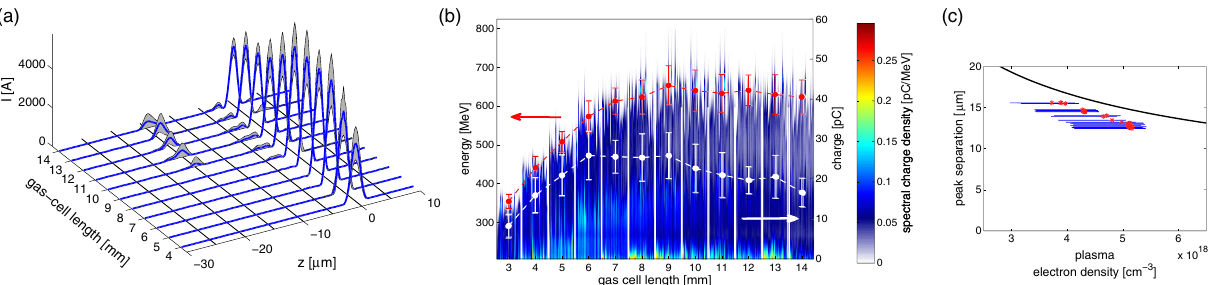
FIG. 4. (a) Bunch profile evolution at a plasma electron density of n e ¼ 3 . 9 × 10 18 cm − 3 : Retrieved bunch profiles averaged over 30 consecutive shots for different gas-cell lengths. The grey band shows (cid:3) 1 σ , where σ is the shot-to-shot standard deviation for each 30-shot data set. (b) Electron energy evolution at n e ¼ 3 . 9 × 10 18 cm − 3 : Measured electron spectra for gas cell lengths between 3 and 14 mm, recorded in 1 mm steps. For each length setting, 30 consecutive electron spectra are plotted as thin vertical lines. Red dots show the average cutoff energy (set to 10% of maximum spectral charge density) at each length; white dots show the average charge. Error bars show the shot-to-shot standard deviation. (c) Measured bunch separation as a function of the plasma electron density at a fixed gas cell length of L ¼ 12 mm: Error bars on the x-axis represent the uncertainty in electron density. Markers show the mean value of the bunch separation obtained in ten individual runs of the Bubblewrap algorithm, each started from a random seed. Error bars on the y-axis represent one standard deviation. The black line shows the plasma wavelength as given by 1D linear theory.